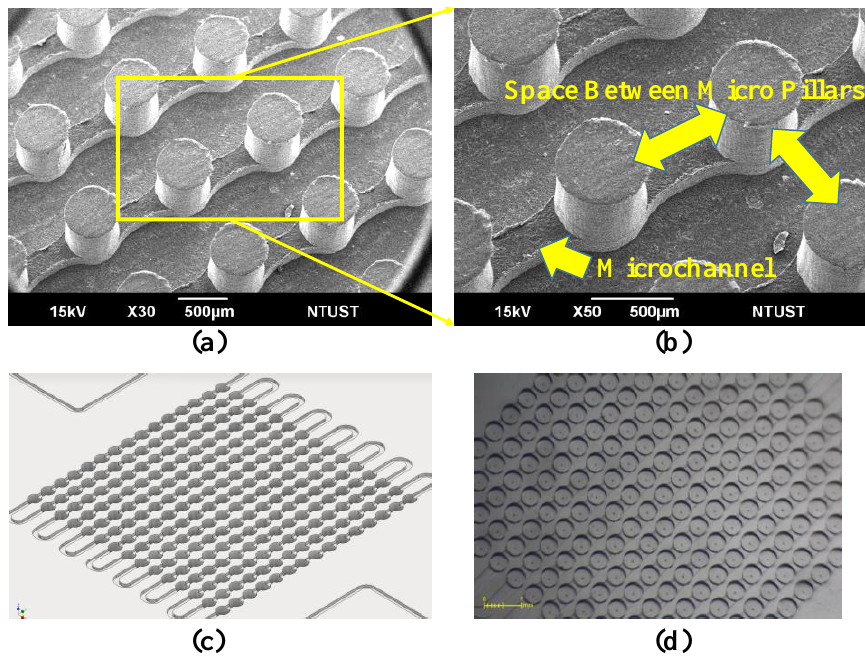
Figure 1. ( a ) SEM image showing standing micro pillars on poly (methyl methacrylate) (PMMA) substrate from our previous study; ( b ) SEM image showing how space between micromilled pillars limited density of microlens arrays (MLAs), the height of the micro pillar is 0.36 mm while the microchannel has 0.4 mm height and 0.4 mm width; ( c ) micro-cavities were drilled into PMMA substrate as an alternative to micro-pillars; and, ( d ) top-view image of micro-cavities drilled into PMMA substrate.